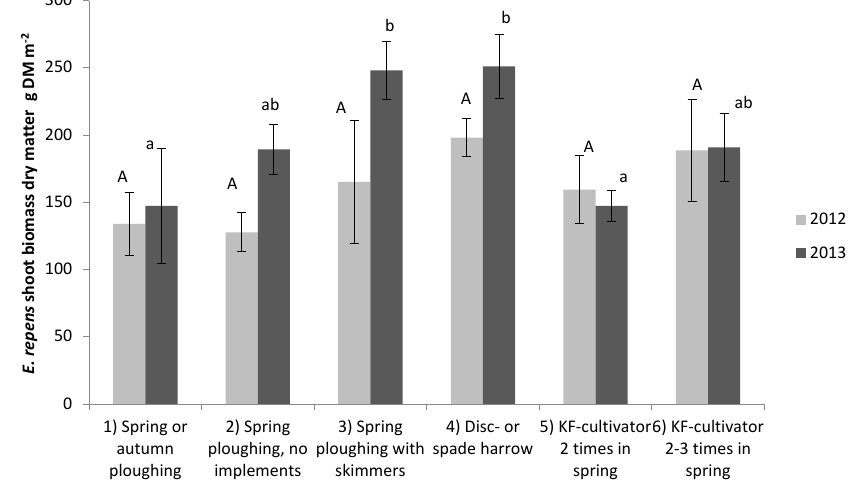
Fig. 1. Average dry matter of E. repens shoot biomass in autumn in experiment 1 (g DM m -2